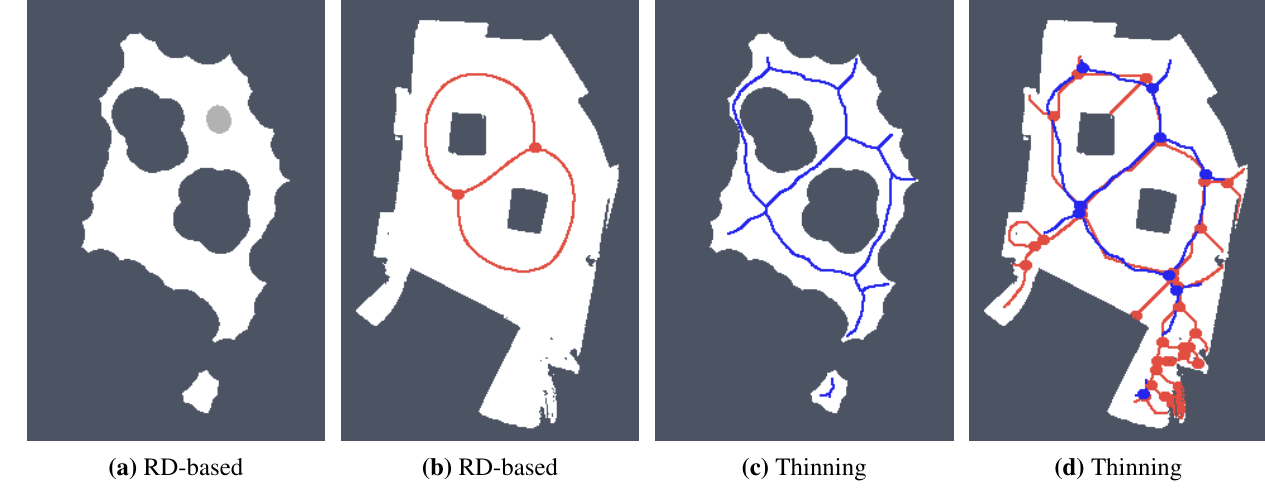
Figure 13. Determined skeletons and topological maps with highlighted junction places and leaves in the map cube with the noise level σ = 8 : ( a ) RD-based Voronoi diagram; ( b ) and its corresponding skeleton (shown in green) that is superimposed on the skeleton determined in the noise-less map (in red); ( c ) Pruned GVG representing skeleton of the map determined by the thinning algorithm [12]; ( d ) and the corresponding skeleton superimposed on the skeleton determined in the noise-less map.